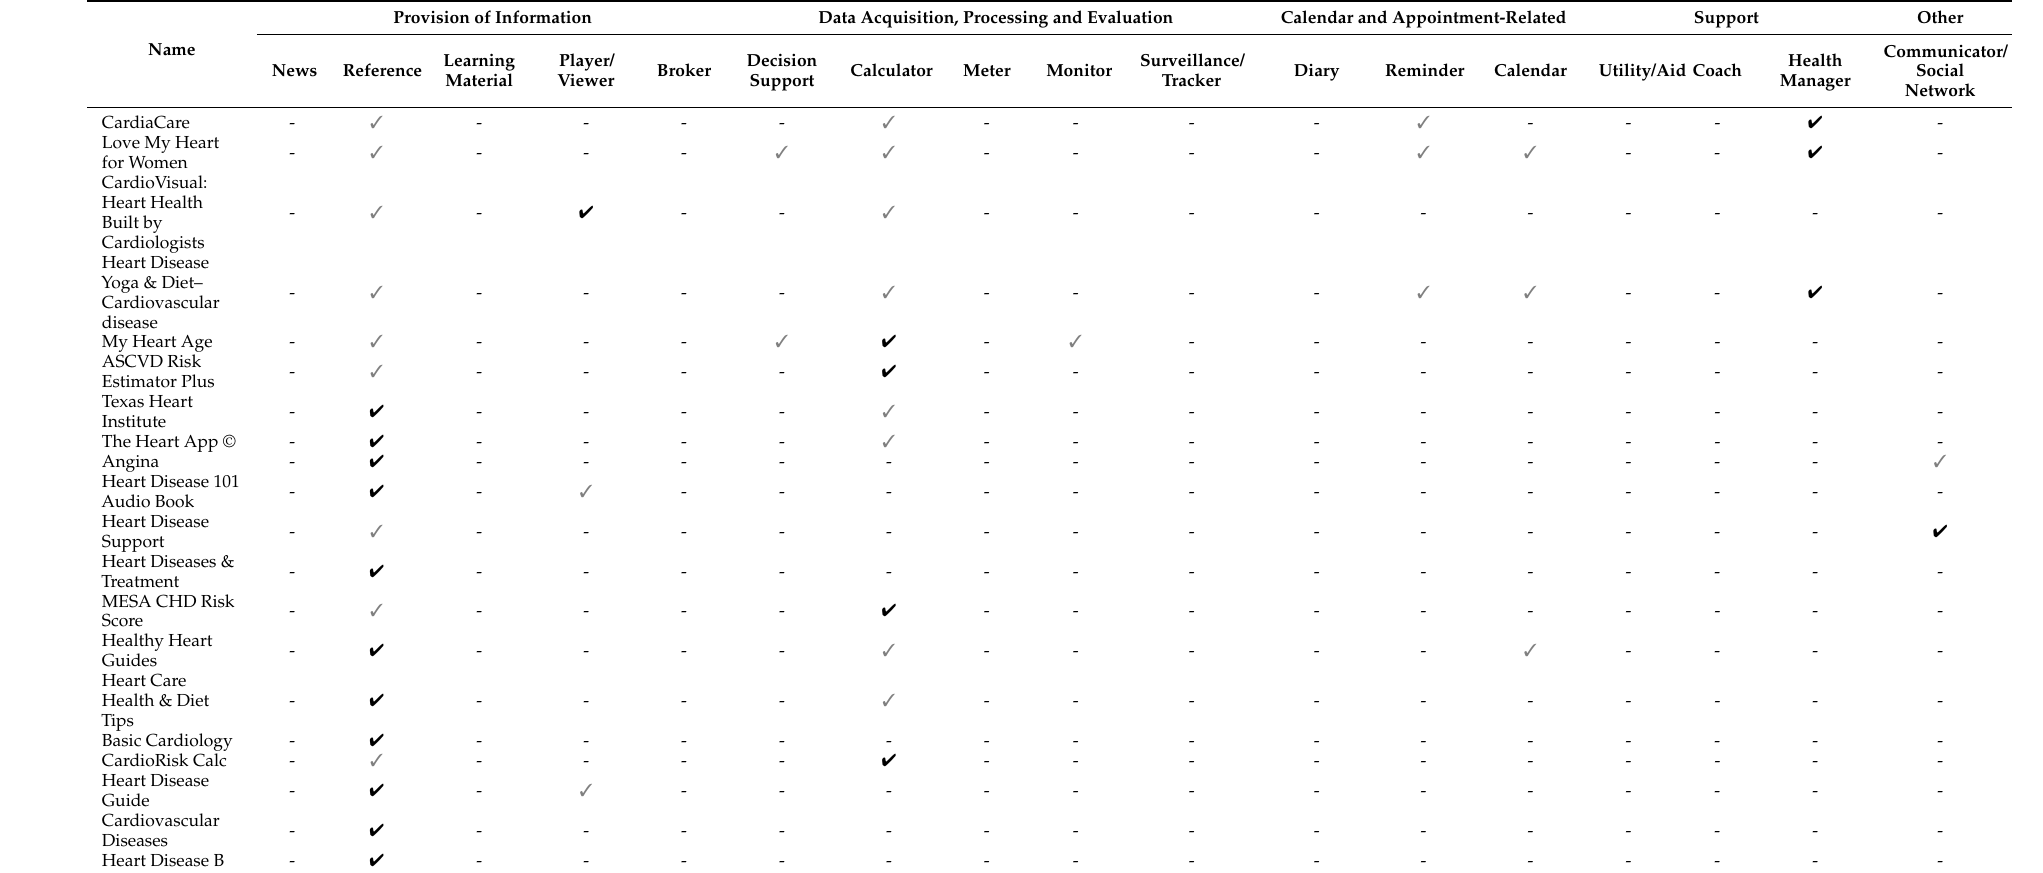
Table A3. Employed functions per included